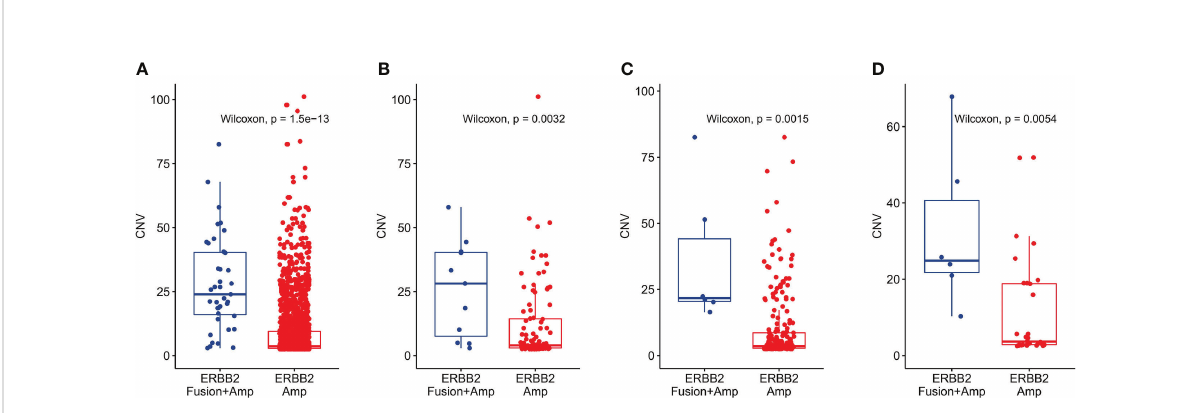
FIGURE 5 CNV difference between solid tumors with only ERBB2 ampli fi cation and tumors with ERBB2 fusion combined with ampli fi cation. (A) CNV difference analysis classi fi ed by ERBB2 fusion status in pan-cancer, (B) CNV difference analysis classi fi ed by ERBB2 fusion status in gastric cancer. (C) CNV difference analysis classi fi ed by ERBB2 fusion status in colorectal cancer. (D) CNV difference analysis classi fi ed by ERBB2 fusion status in breast